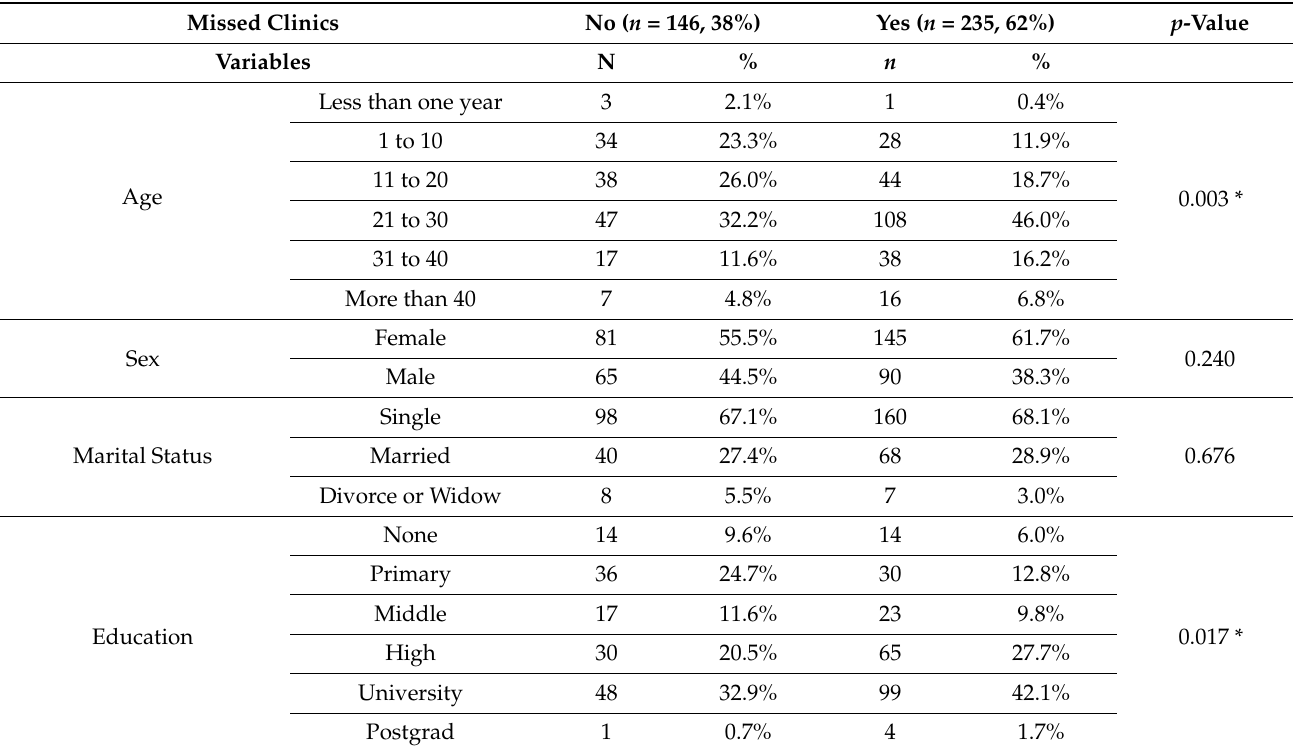
Figure 4. Factors that improve clinic attendance for participants with SCD. Table 2. Comparison between individuals who reported missed clinic appointments and those with better adherence for